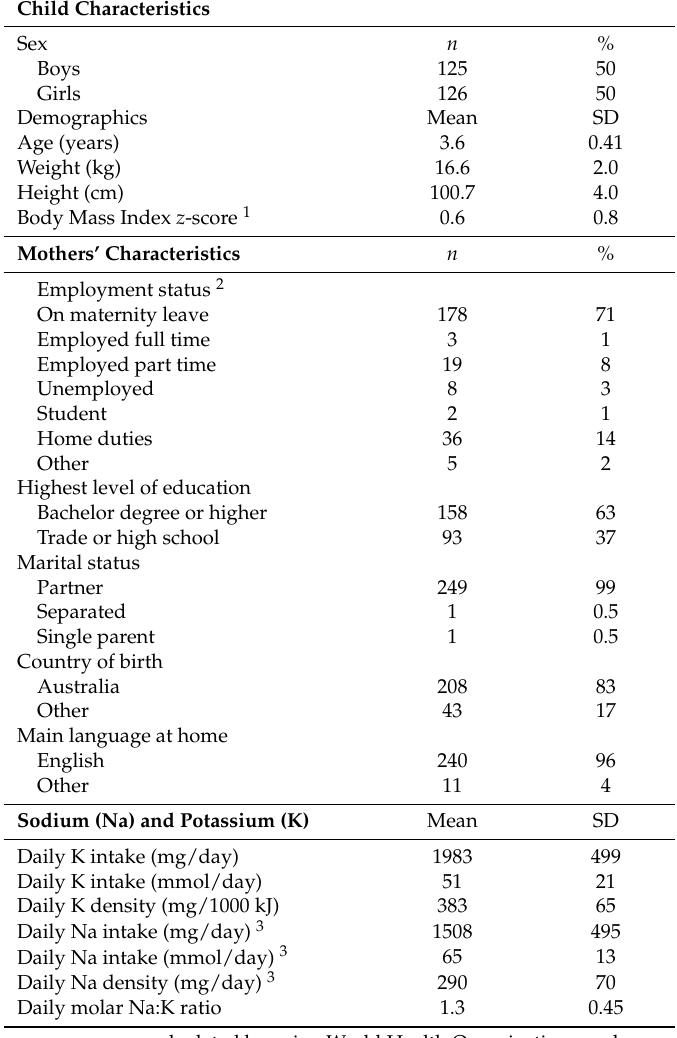
Table 1. Characteristics for children and mothers who participated in follow-up data collection when the children were 3.5 years old.